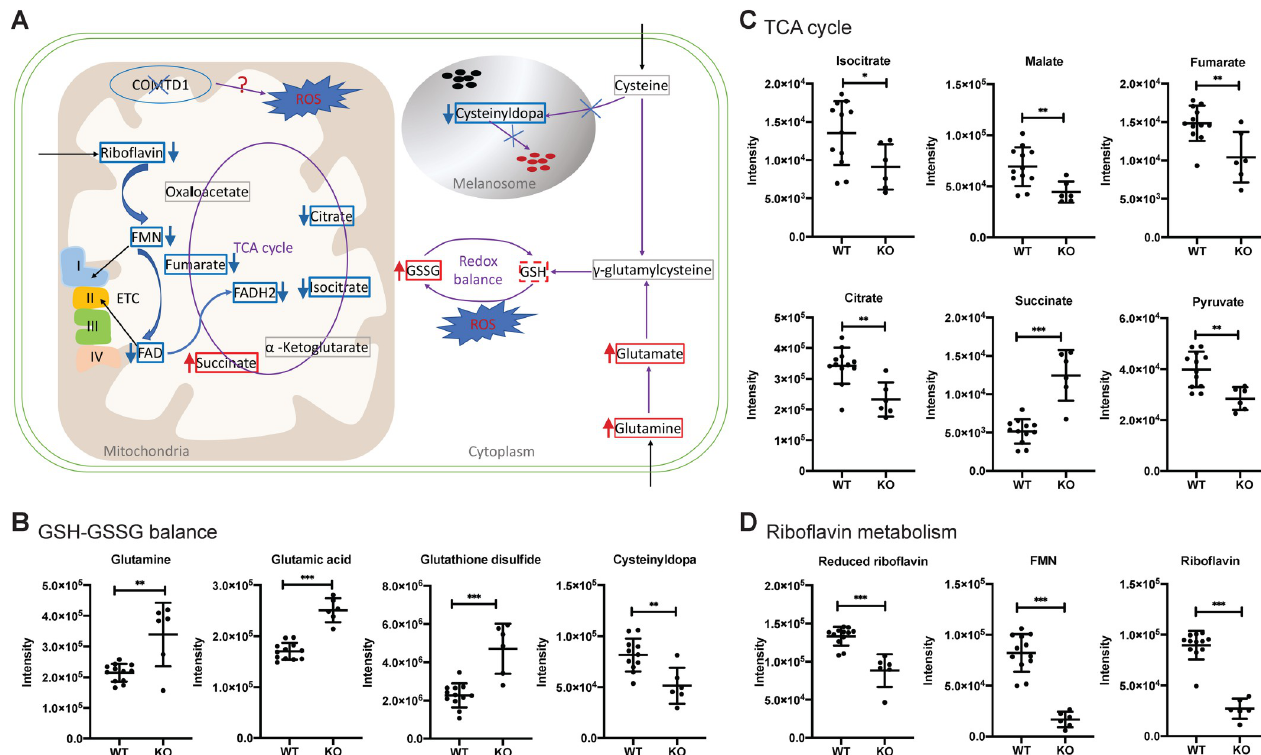
Fig 7. Metabolomics analysis reveal several metabolic pathways involved in oxidative stress that are altered in Comtd1 -KO B16F10 cells. (A) Schematic representation of possible impact on biosynthesis of pheomelanin by COMTD1. Upregulated metabolites are highlighted in red and downregulated in blue. The solid and dashed lines denote significant and nonsignificant difference, respectively. ( B-D) Mass spectrometric peak intensity of the corresponding metabolites in wild-type and knockout cell lines. Data are presented as mean ± SD from experimental replicates (N = 6 in KO; N = 12 in WT). ns: not significant, P > 0.05; * : P < 0.05; ** : P < 0.01; *** : P < 0.001. Peak intensity of metabolites was acquired by UPLC-MS